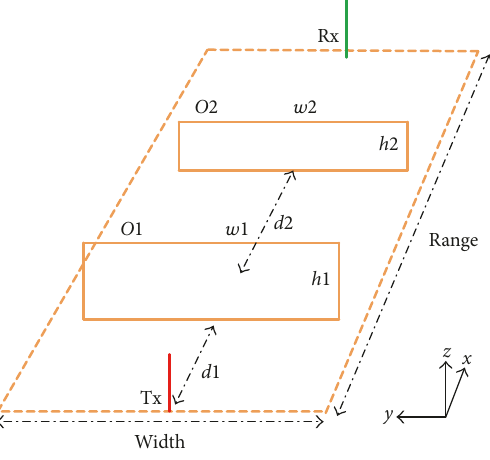
Figure 2: Knife edge